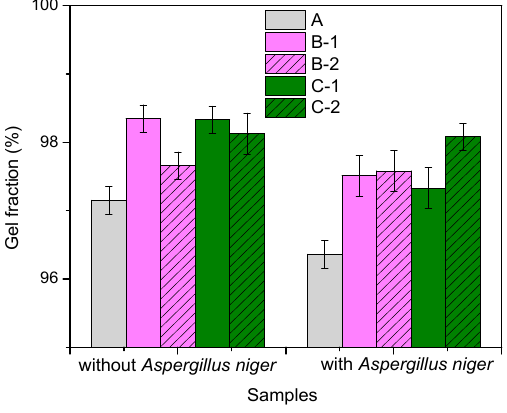
Figure 4. Gel fraction of the composites before and after incubation with Aspergillus niger .